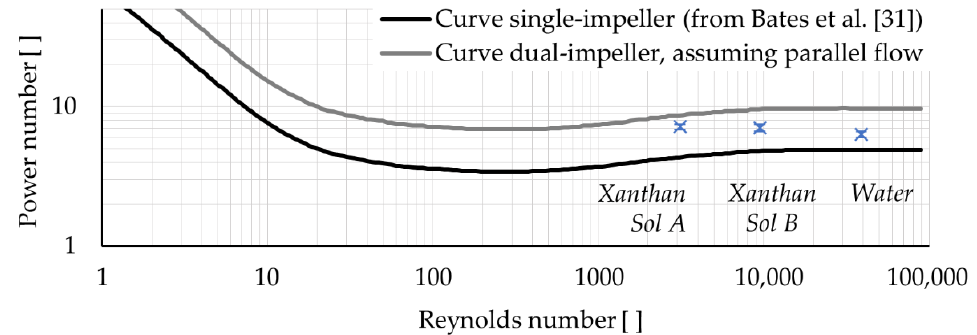
Figure 6. Power number curve analysis of the abiotic systems. Single-impeller curve was plotted as reported by Bates et al. [31].